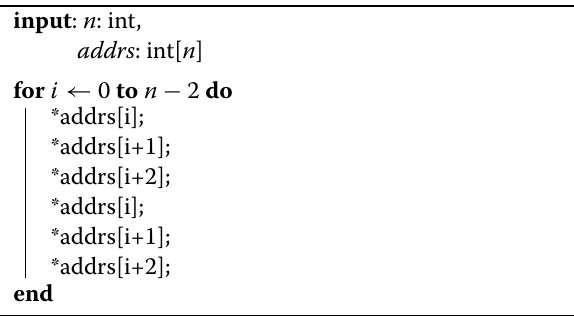
Algorithm 3: Attacker accessing a set.